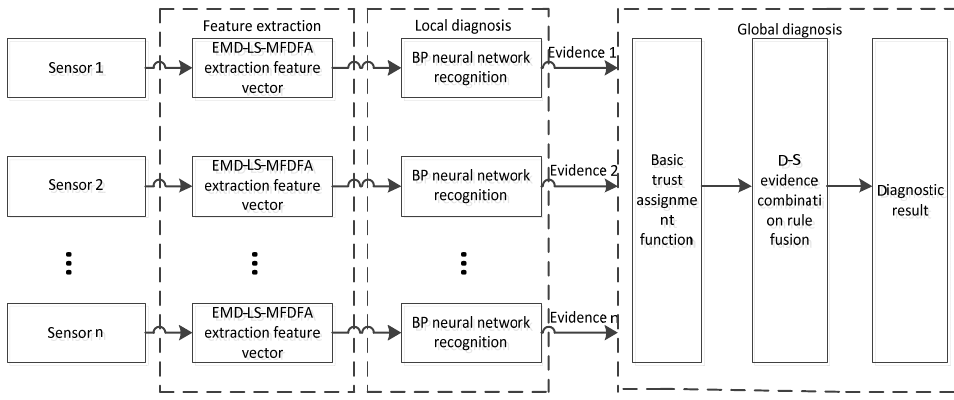
Figure 3. Fault diagnosis model.